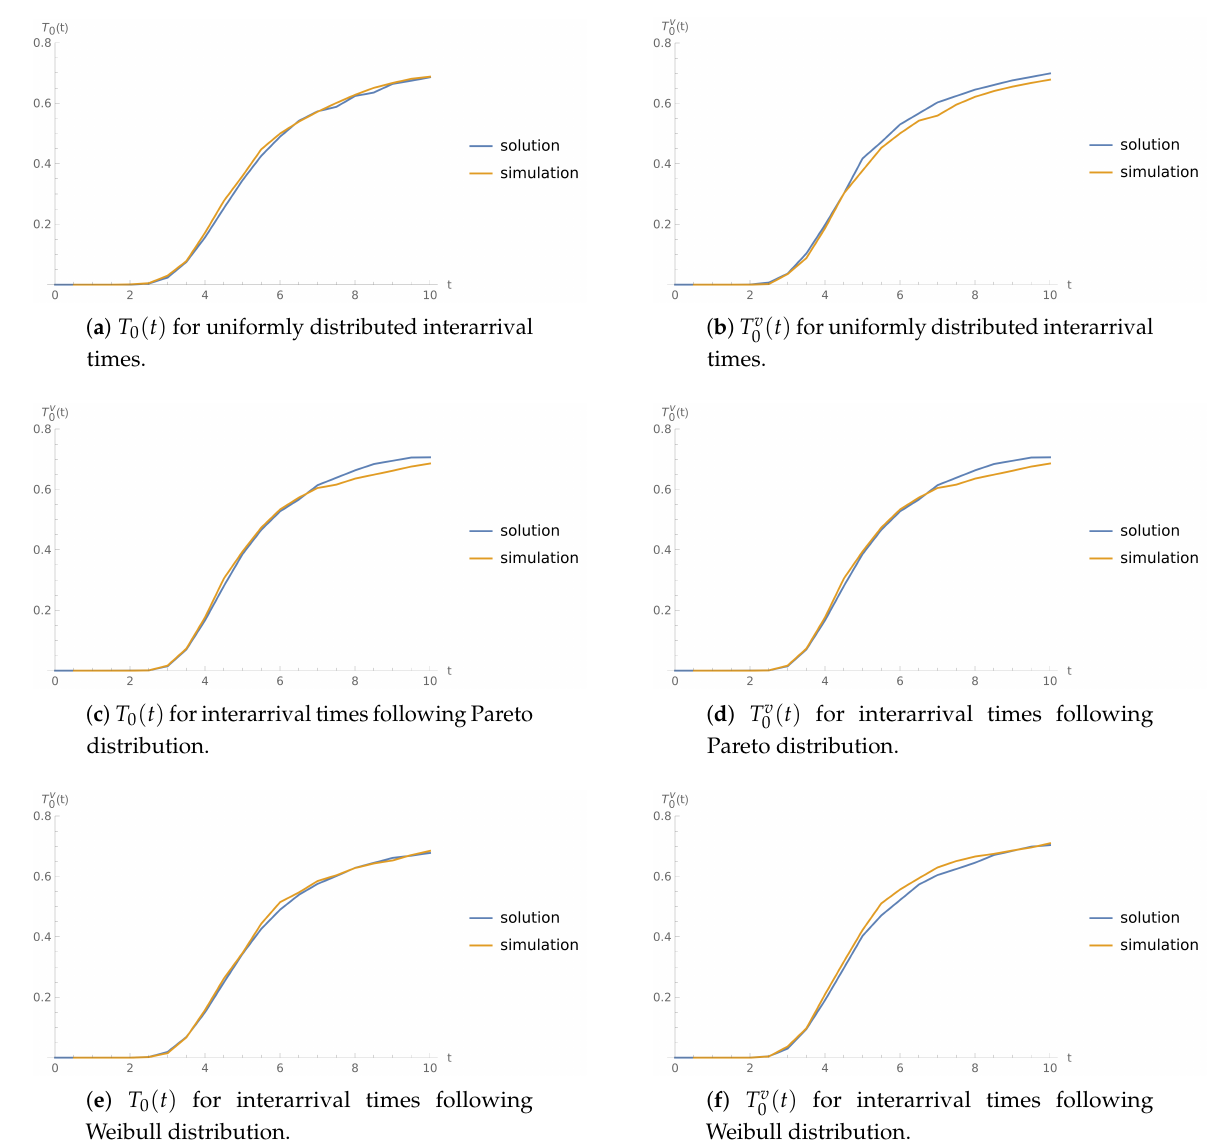
Figure 7. CDFs of the time to buffer overflow for µ = 17, µ v = 9, and 1/ α = 7. Method results and simulated